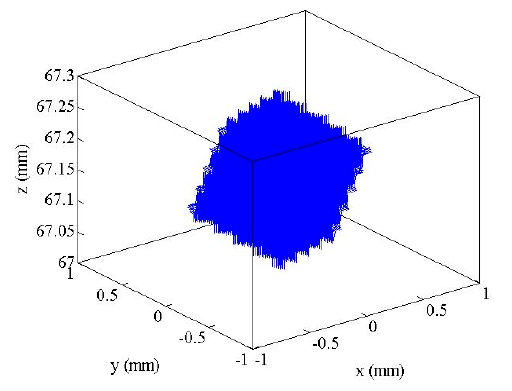
Figure 10. 3-SPR workspace.